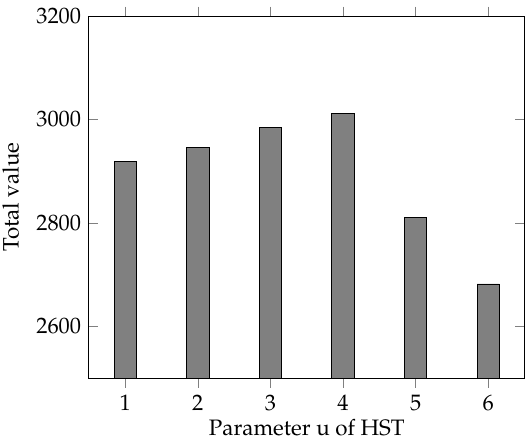
Figure 9. The effect of different value of